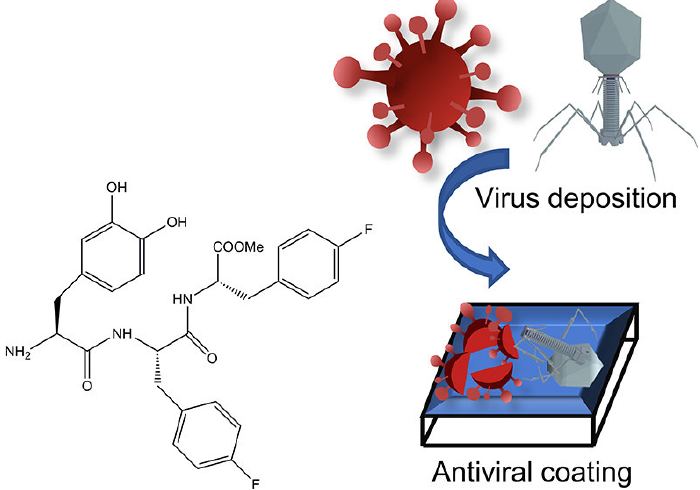
Figure 13. Schematic showing the structure of DOPA-Phe(4F)-Phe(4F)-Ome which utilizes fluorinated phenylalanine residues to kill viruses by forming an antiviral coating when applied to a surface. Reprinted with permission from [71]. Copyright 2021 American Chemical Society. Reprinted with permission from [71]. Copyright 2021 American Chemical